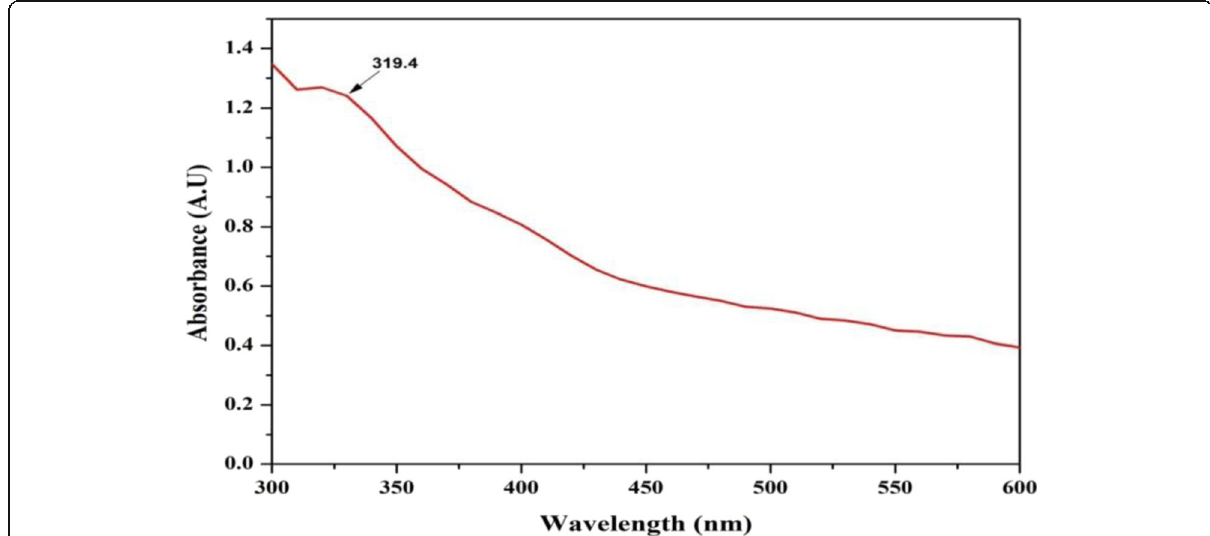
Fig. 2 λ max was examined using UV-Vis spectrophotometer of biosynthesised selenium nanoparticles